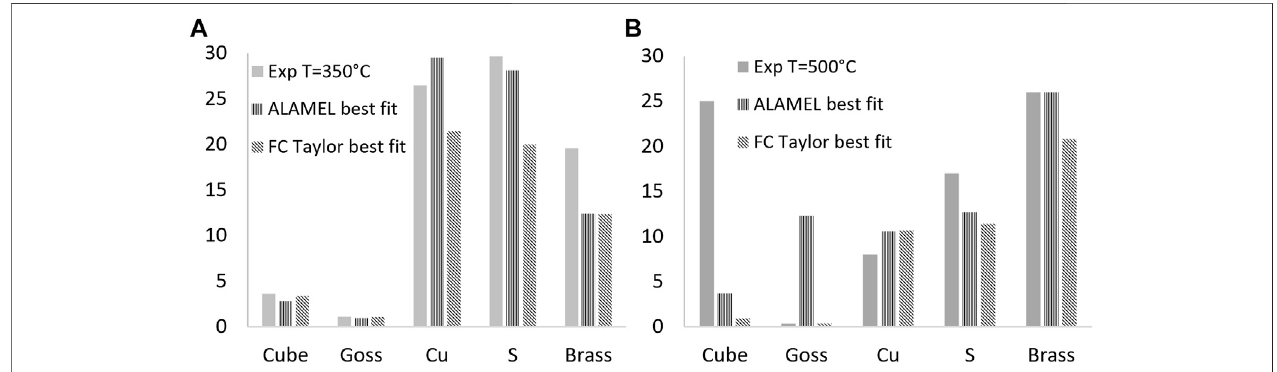
FIGURE 6 | Predicted and measured texture component intensities for (A) AA6063 T 350 ° C, (B) AA6082 T 500 ° C.